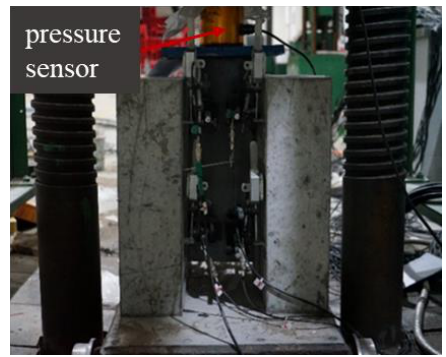
Figure 3. Loading device used for the push-out tests.